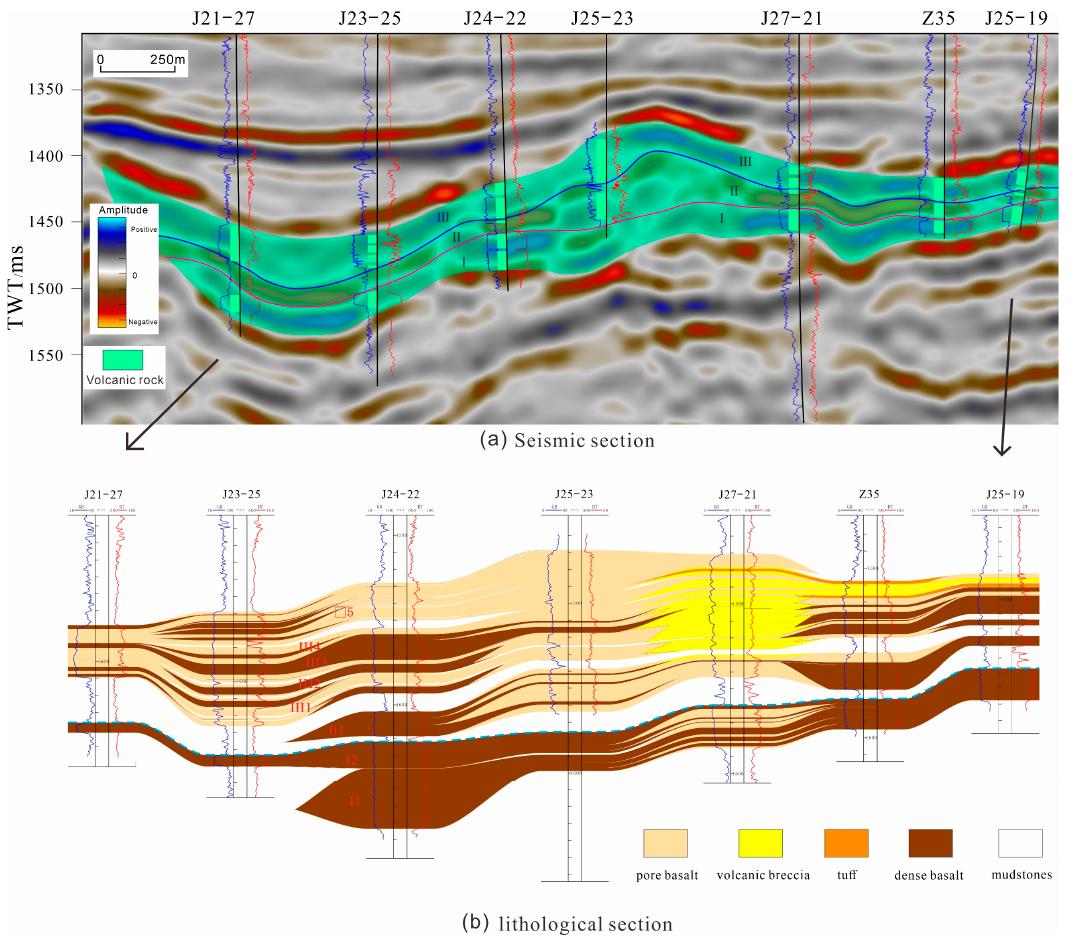
Figure 9. Sections of the volcanic eruption stages of the Zao35 fault block. ( a ) response characteristics of volcanic stages on seismic profiles; ( b ) lithological distribution characteristics within the sub-stages.